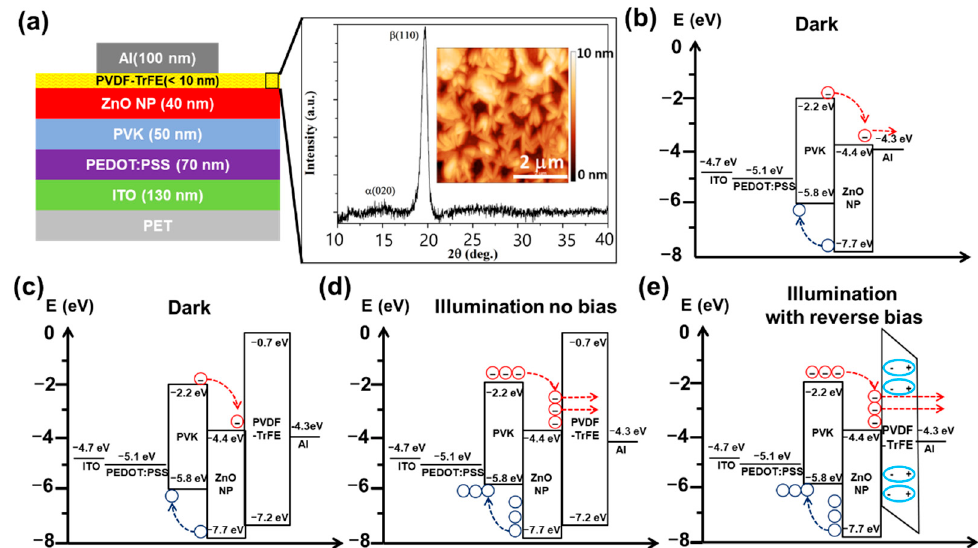
Figure 1. ( a ) Schematic illustration of device structure for hybrid PD with PVDF-TrFE. Inset shows XRD pattern and AFM image of the PVDF-TrFE layer on top of the ZnO NP layer. Energy band diagram of hybrid PD ( b ) without PVDF-TrFE and ( c ) with PVDF-TrFE under dark conditions. Energy band diagram of hybrid PD with PVDF-TrFE under illumination ( d ) with no bias and ( e ) with reverse bias.